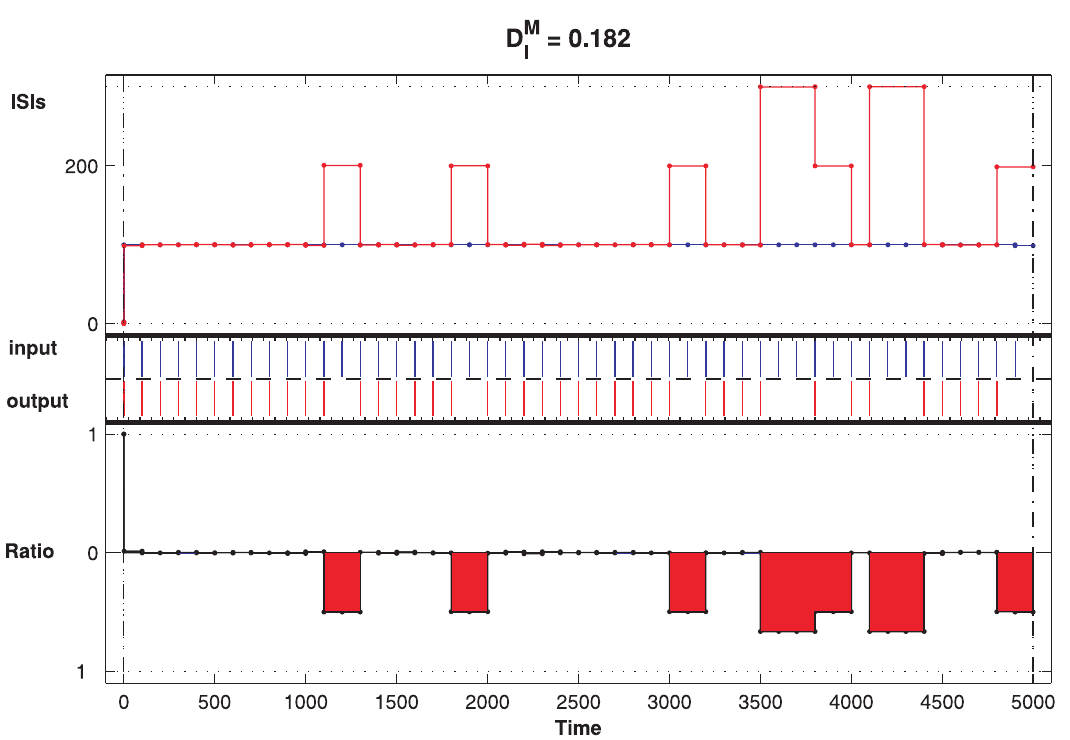
Figure 8. CD neuron fails to follow the network input. For T w ~ 2 : 0 ms and h ~ 30 , the red color denotes that CD neuron cannot detect the synchrony of its inputs properly but is slower than the input of the network.